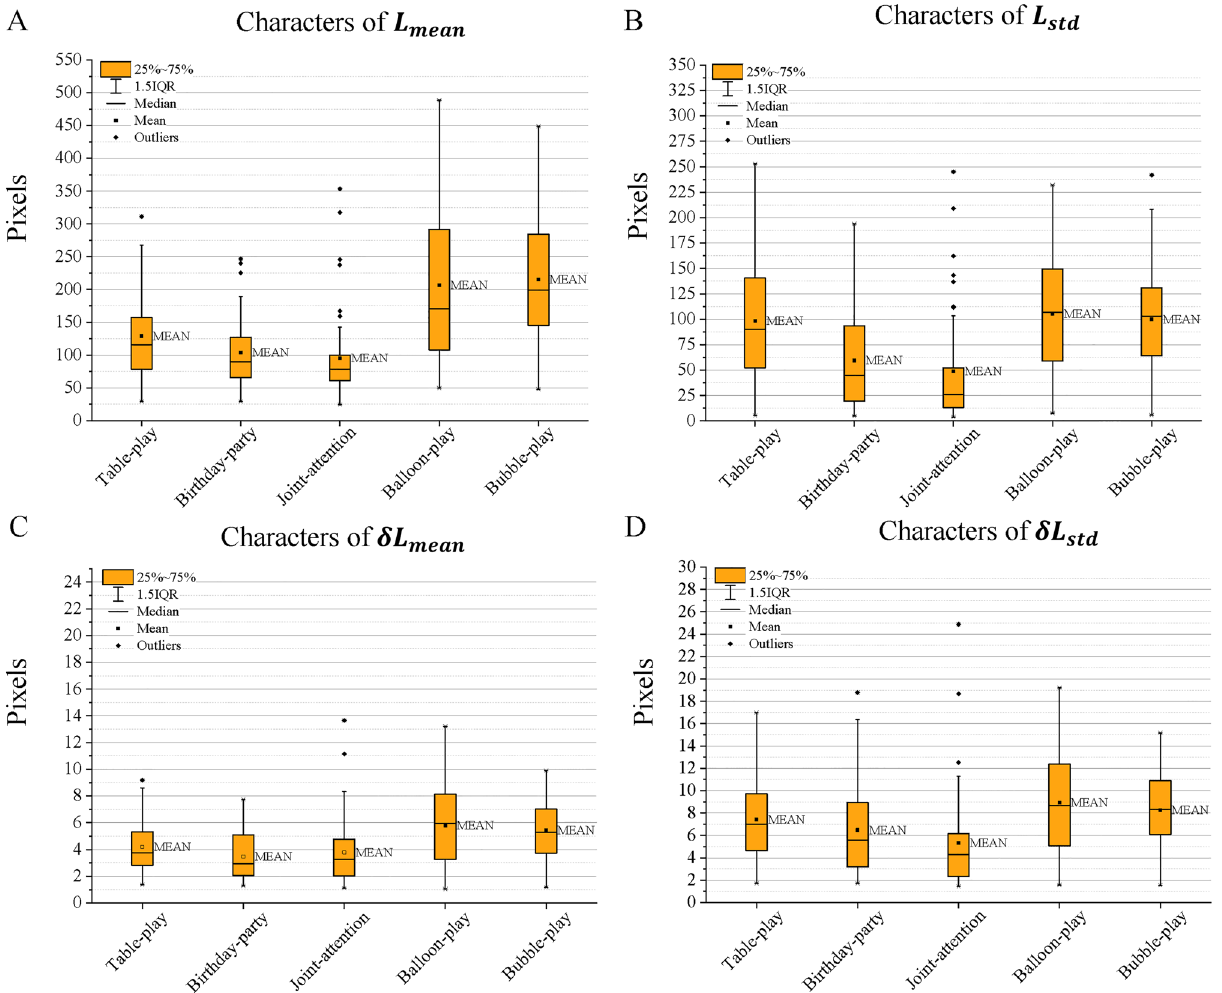
Figure 4. The characteristics of four MFs at the neck key point in different activities: ( A ) L mean , ( B ) L std , ( C ) δ L mean , and ( D ) δ L std